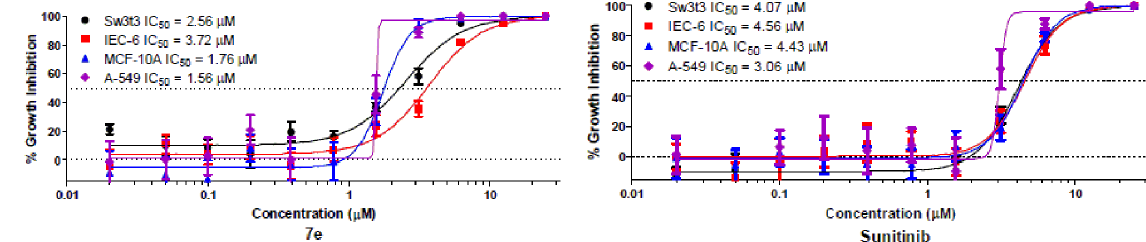
Fig 7. Tumor cell selectivity. Dose-dependent growth inhibitionby 7e or sunitinibin a NSCLC cell line (A-549) comparedwith three non-tumorigenic cell lines: Sw-3t3 (murine fibroblasts), IEC-6 (murine inestinalepithelialcells), or MCF-10A (human mammary